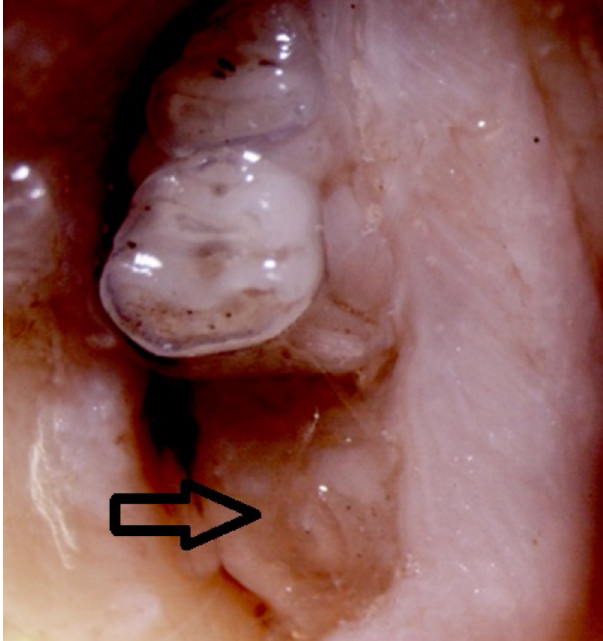
Fig. 1. Extraction socket of left fi rst mandibular molar on day 7. Epithelial coverage over the extraction socket is evident (black